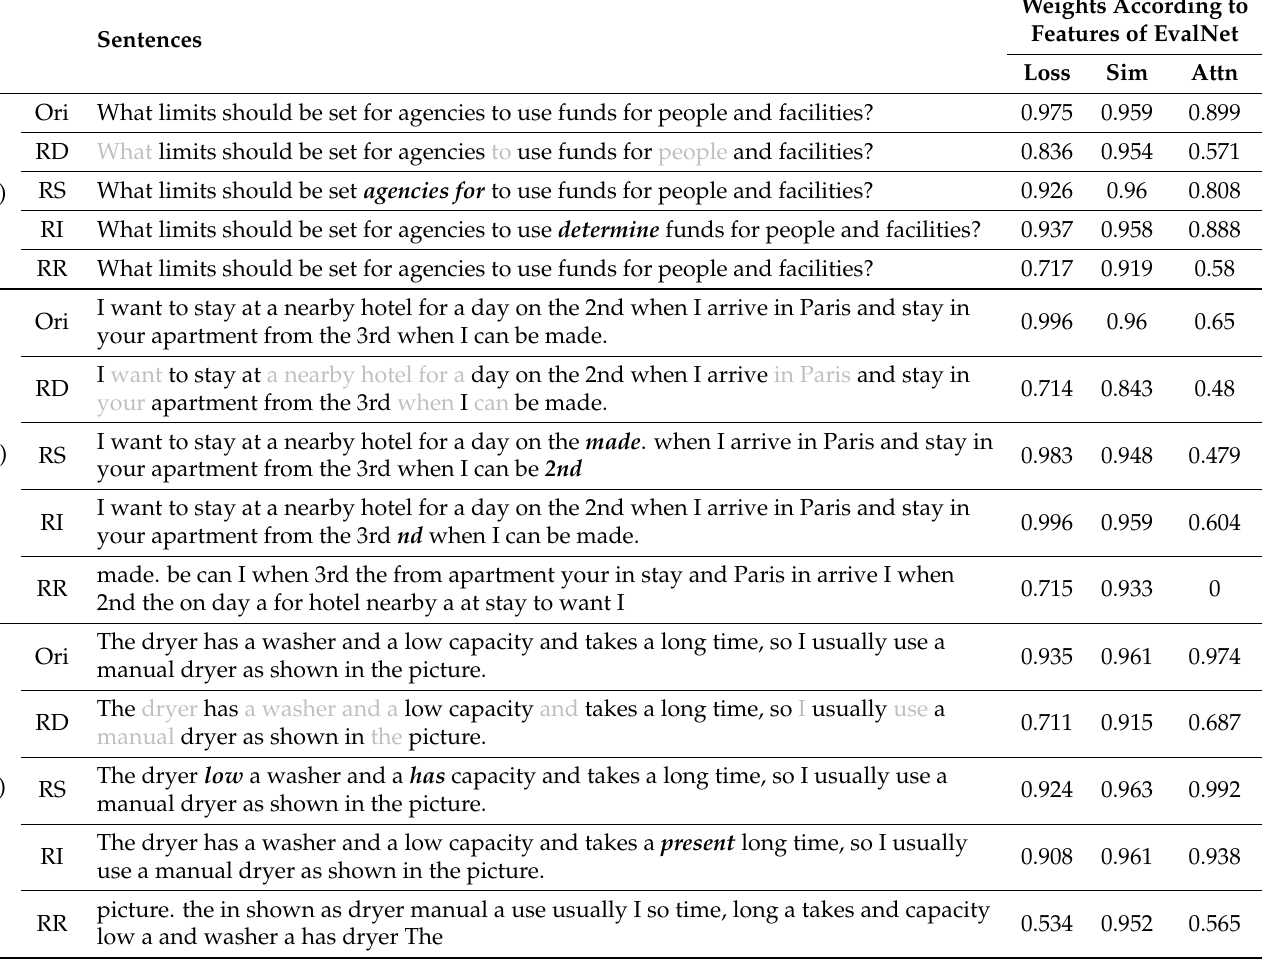
Table 5. Examples of noisy variations and weights according to the features of